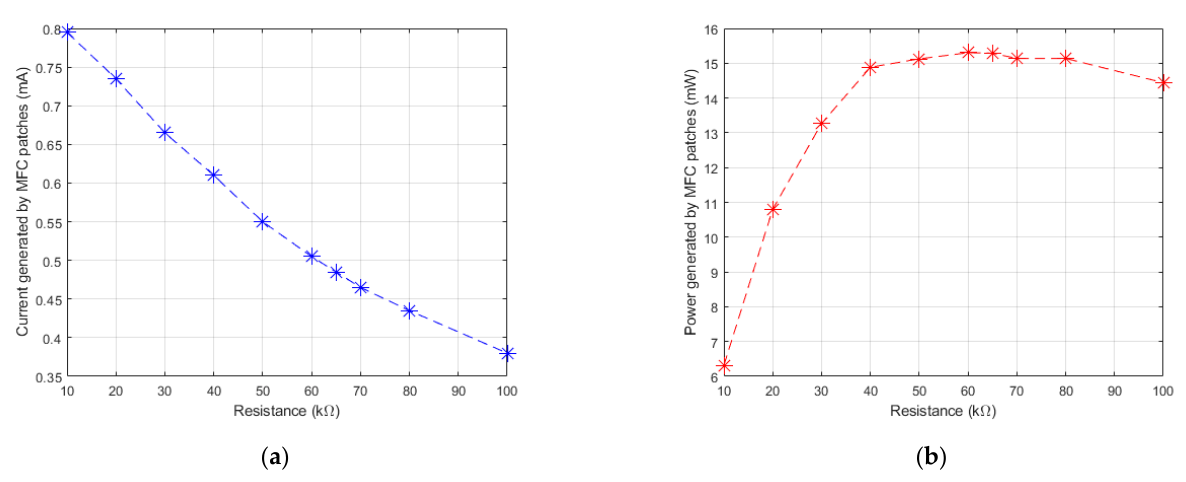
Figure 7. Energy-harvesting process: ( a ) Average current generated by MFC patches; ( b ) Power generated by MFC patches.